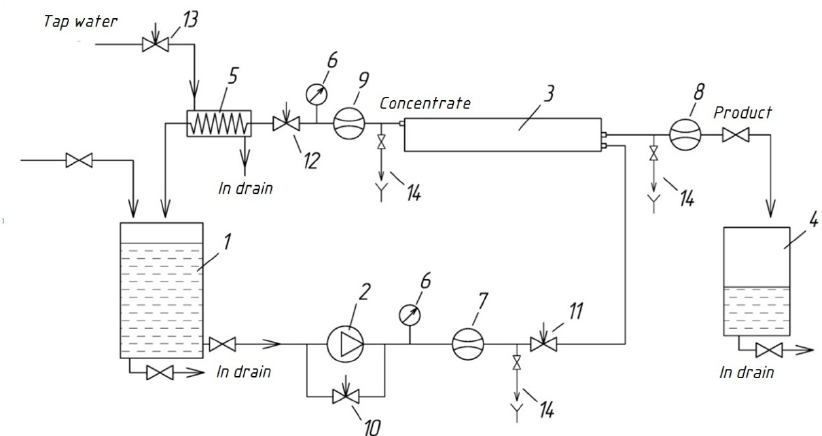
Figure 2. Schematic diagram of laboratory RO unit for membrane scaling tests: 1 - feed water tank; 2 - pump; 3 - spiral wound membrane module; 4 - permeate tank; 5 - heat exchanger; 6 - pressure gauge; 7- feed water flow meter; 8 - permeate flow meter; 9 - concentrate flow meter; 10 - by-pass adjusting valve; 11 - feed water adjusting valve; 12 - concentrate adjusting valve; 13 - cooling water adjusting valve; 14 - sampler.